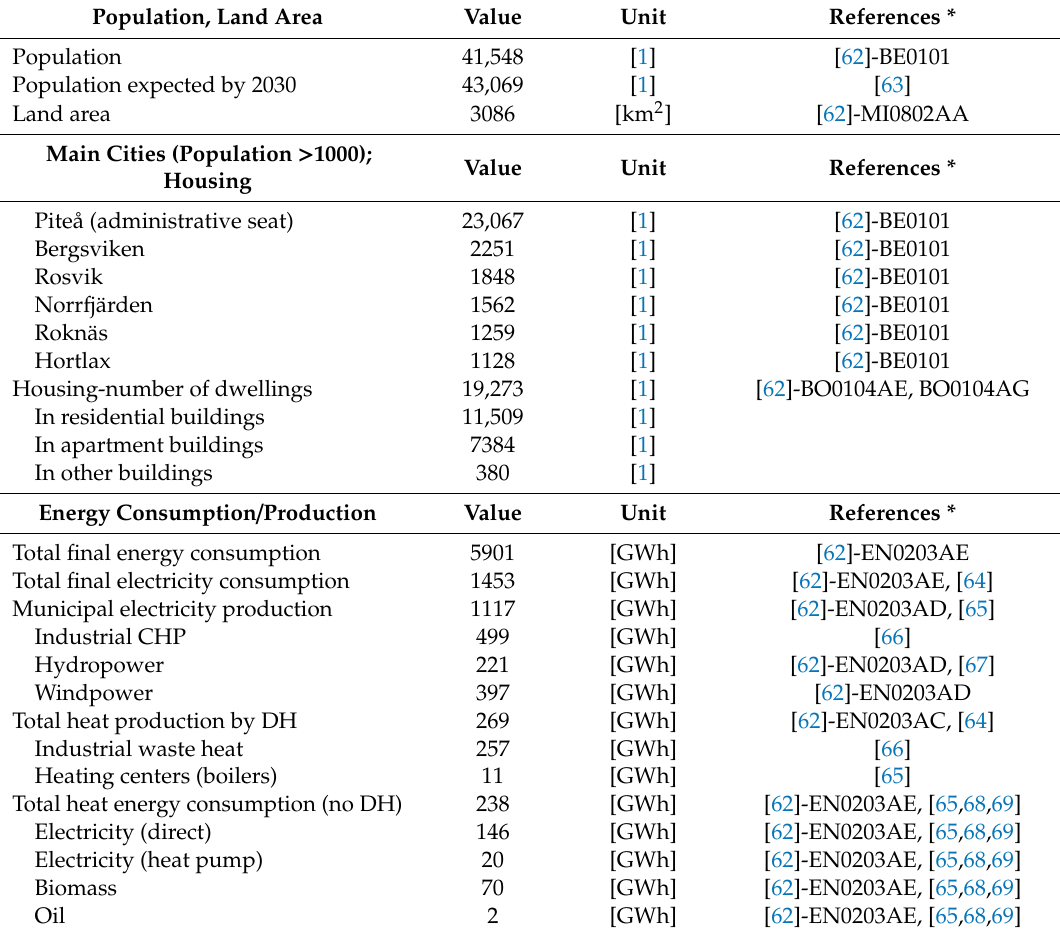
Table 2. Piteå municipality, key figures